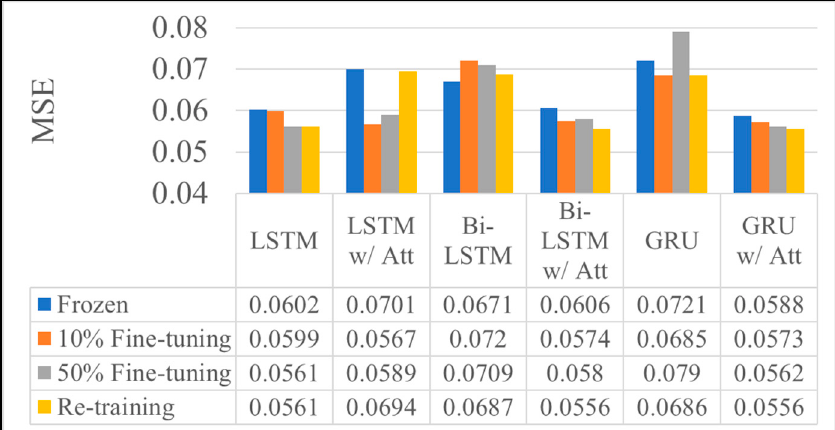
Figure 9. MSE of the source disease course prediction of TL-CDC under k = 2.